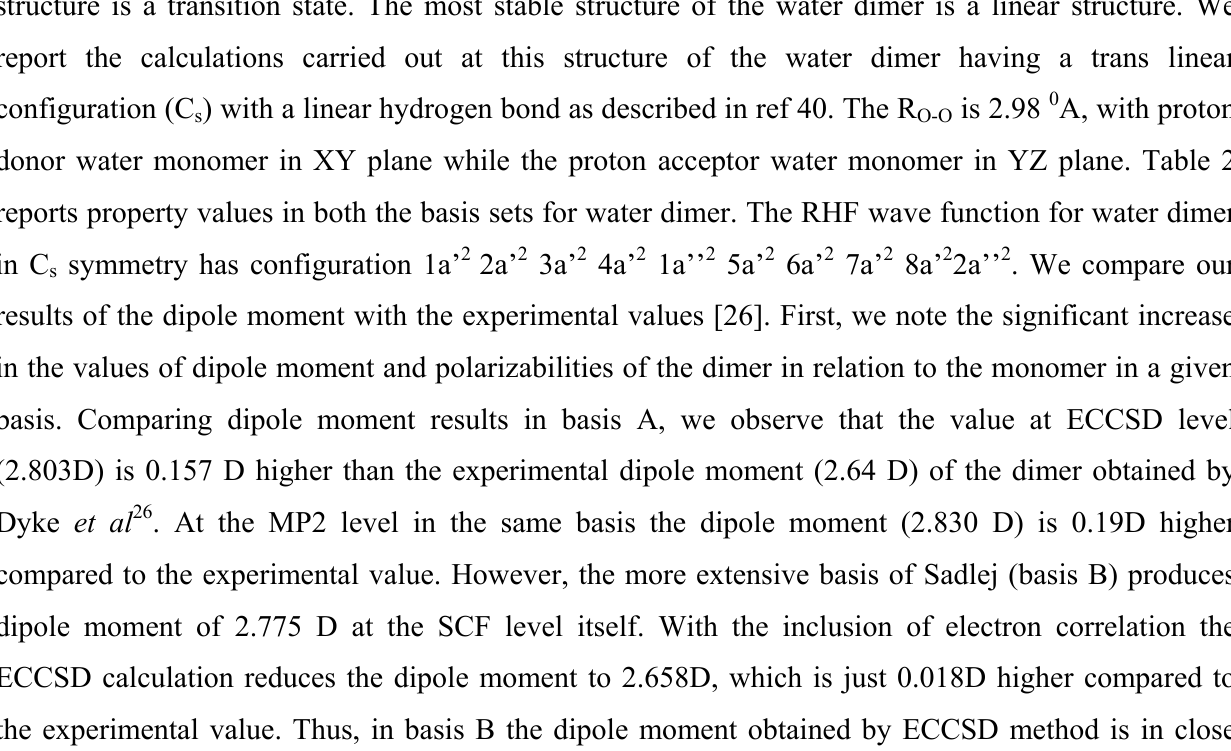
Table 1. Property values for H